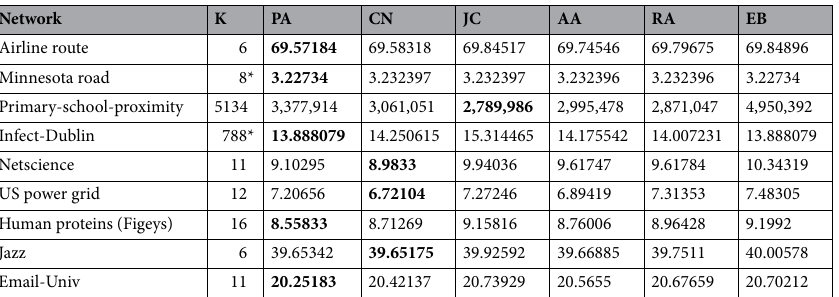
Table 4. Largest Eigenvalue computed for the network after removing minimum number of links cutting the network , k , using reverse link prediction methods and EB . Star numbers for k column stand for greater value of k because of the inefficient number of edge removals to discriminate the (cid:31) m for methods. The best value of (cid:31) m for each dataset has been bolded.